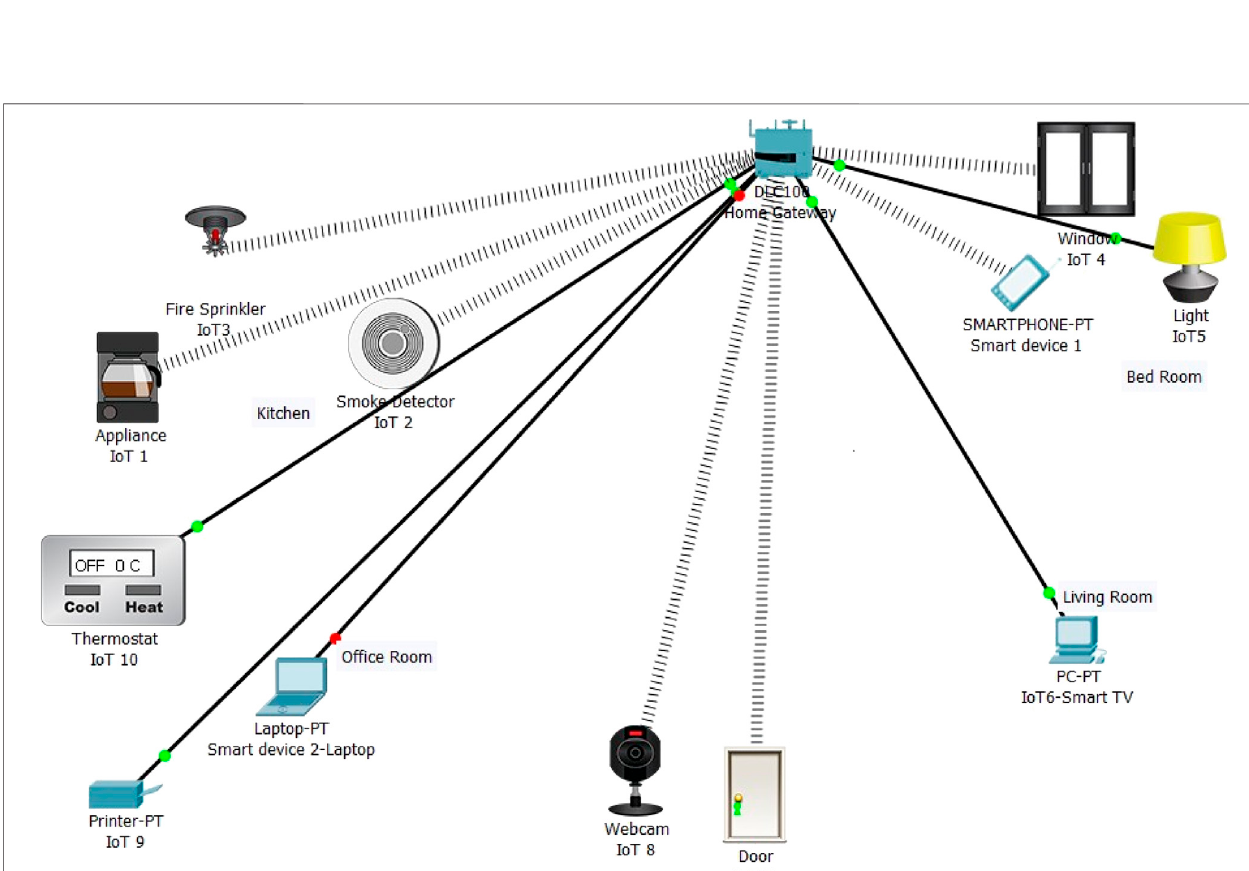
FIGURE 2 | Con fi guration of IoT and smart devices in Cisco packet tracer connected to home gateway for the simulated model.